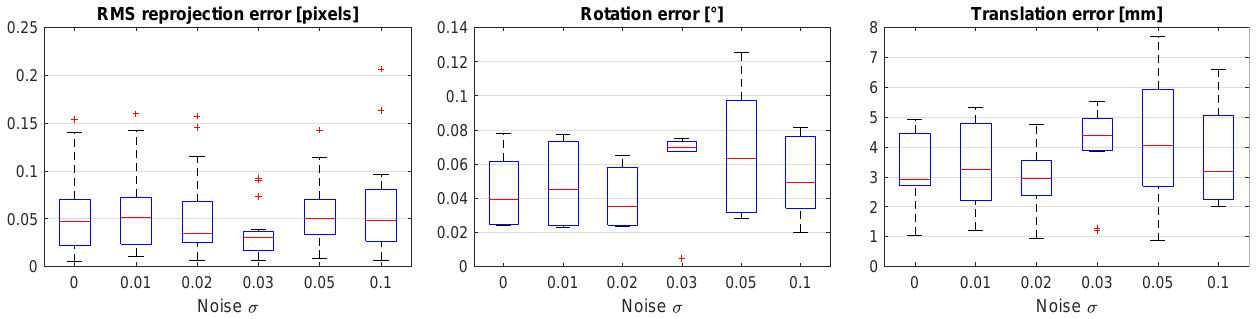
Figure 7. Results when varying the standard deviation σ of the Gaussian